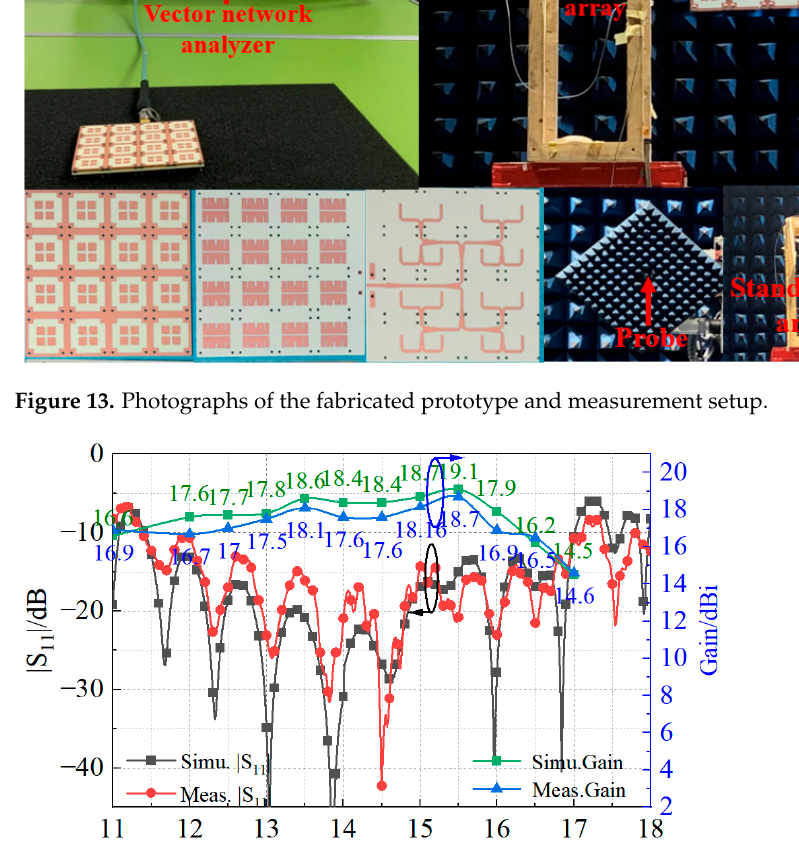
Figure 14. Comparison between simulated and measured re fl ection coe ffi cient magnitude.